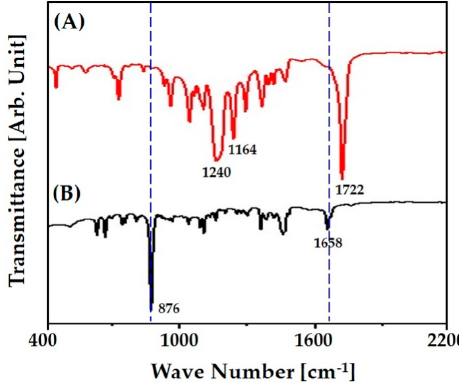
Figure 5. FT-IR spectra of ( A ) the PCL scaffold and ( B ) camphene.